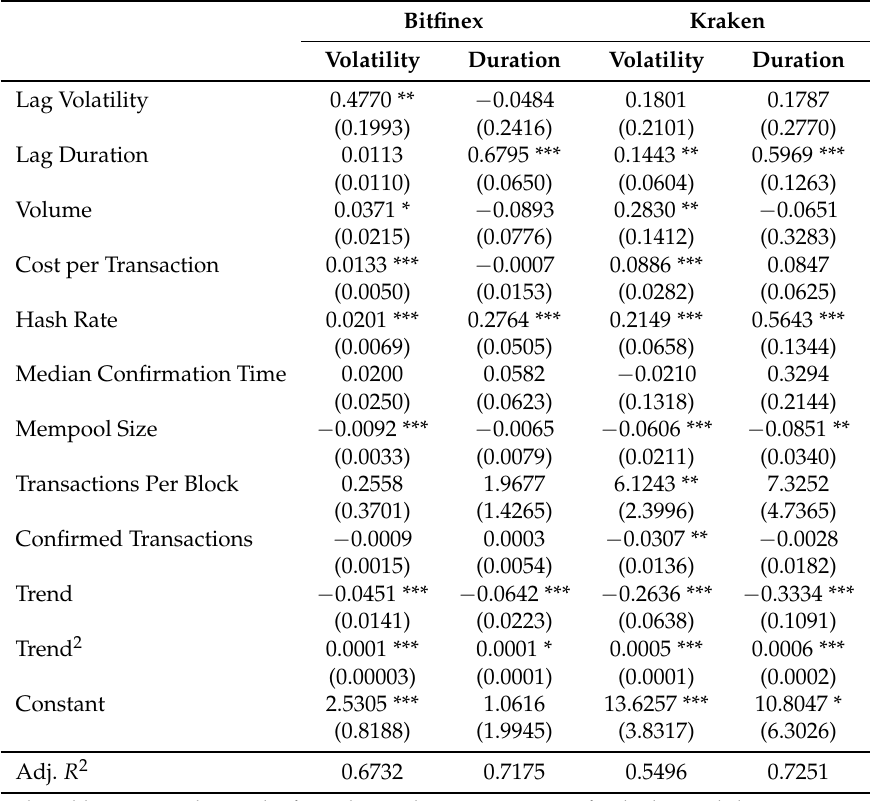
Table 3. Predictive regression